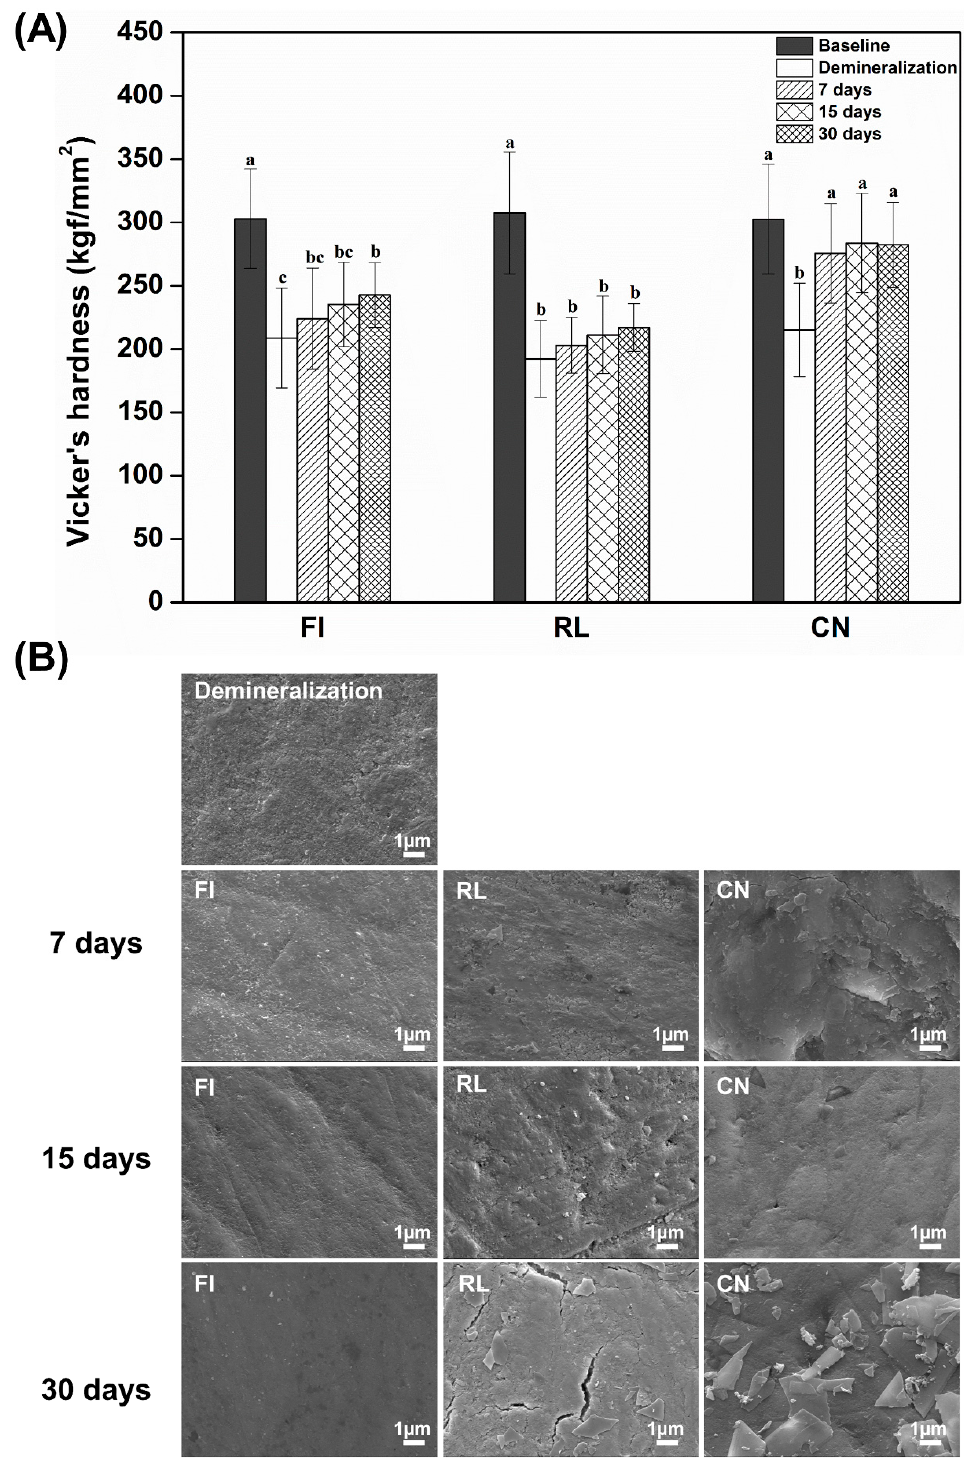
Figure 5. Microhardness of enamel surface filled with each restorative material ( A ). Each value indicates the mean of 10 measurements, and the error bars represent the standard deviation of the (mean ± standard deviation; n = 10). Differences in lowercase alphabetical letters above the bar graph indicate differences comparing periods for the same groups ( p < 0.05). Representative images of enamel surface after the remineralization process ( B ).